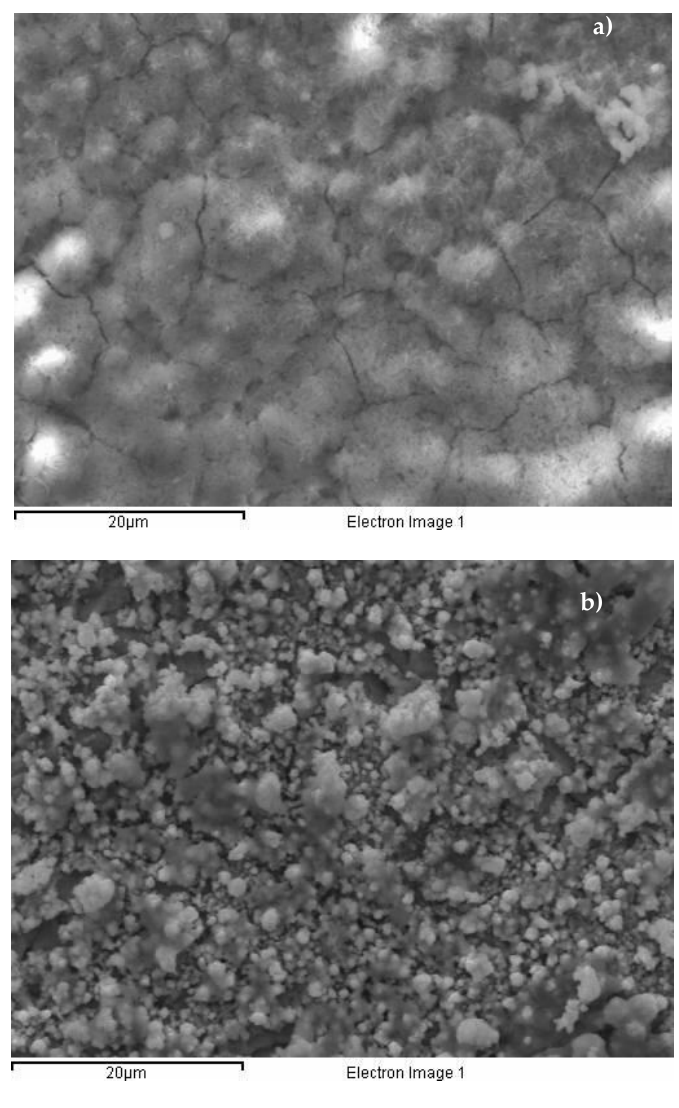
Figure 8. SEM images showing the surface morphologies for ( a ) a B (as-cast) sample and ( b ) a BR (annealed) sample after cyclic voltammetry in 3.5 wt.% NaCl solution.